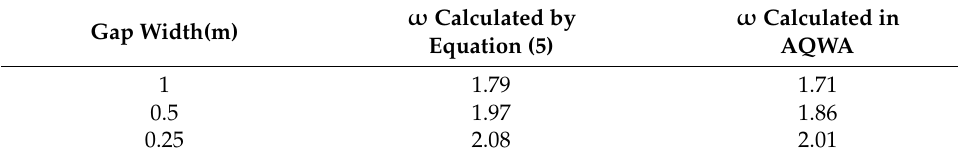
Table 2. Resonance frequency calculated by Equation (5) and